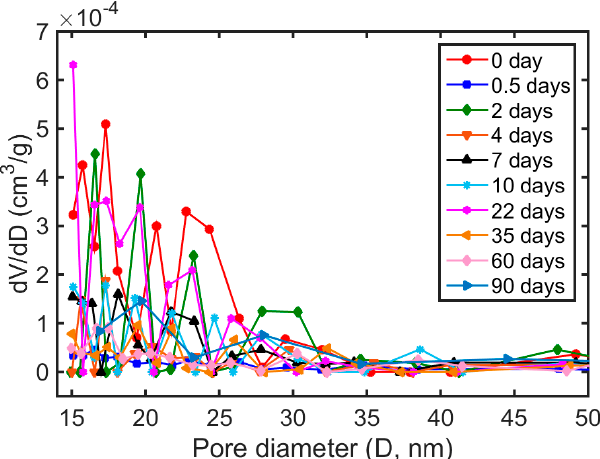
Figure 11. Pore distribution of paper thermally aged for various durations at 130 °C.